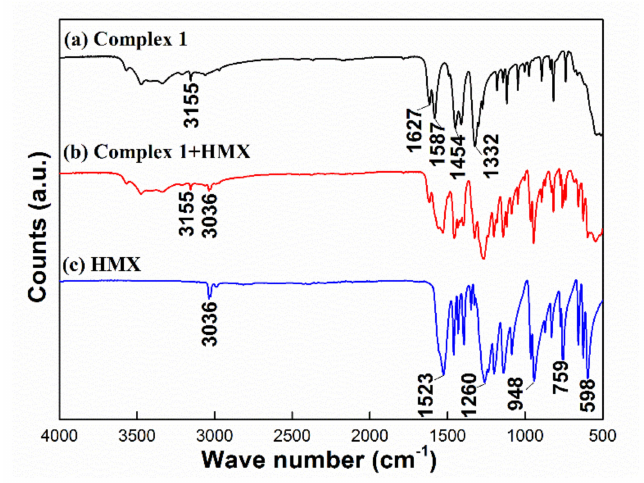
Figure 8. FTIR curves of complex 1 ( a ), complex 1 and HMX ( b ), and HMX ( c ).